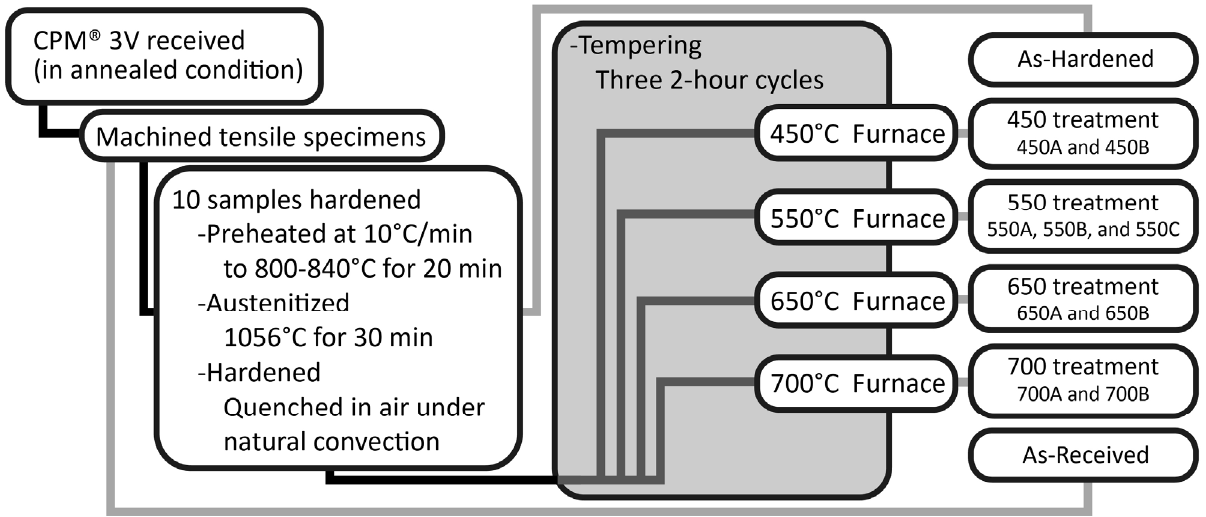
Figure 2. Flow chart showing the heat treatment steps. Tempering temperature was changed between sample sets.